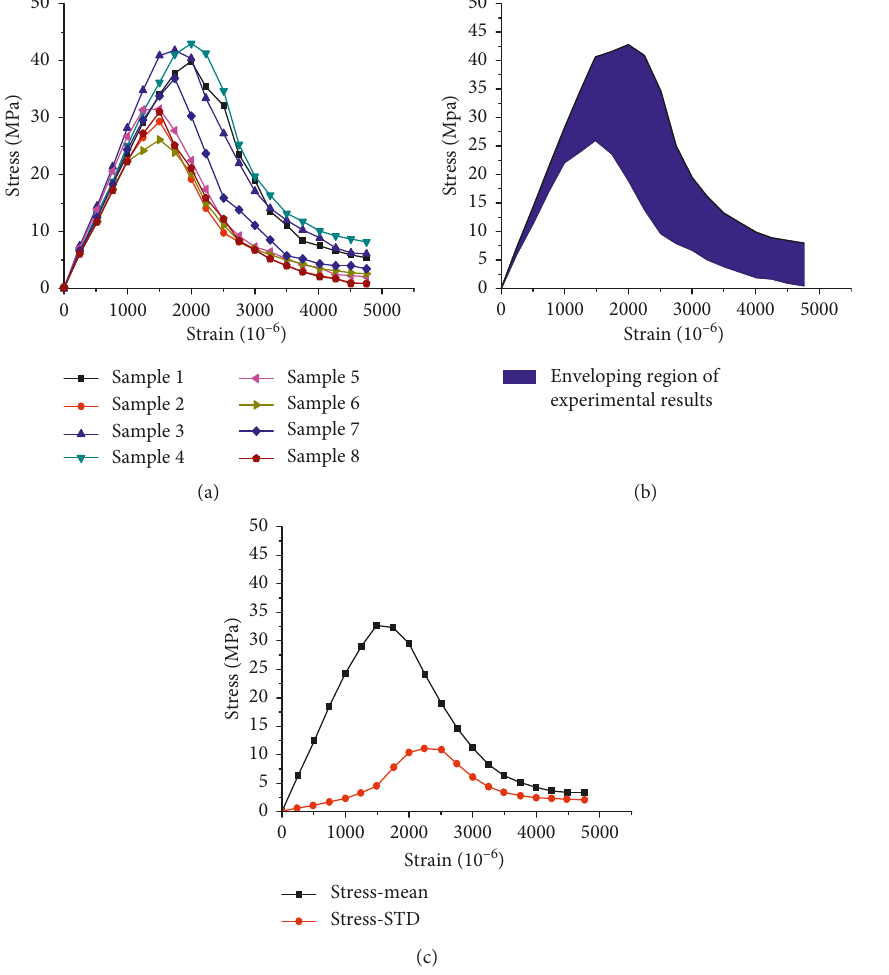
Figure 3: Experimental results of SCC samples under monotonic compressive loads. (a) σ − ε curves. (b) Enveloping region of σ − ε . (c) Mean and STD of σ − ε